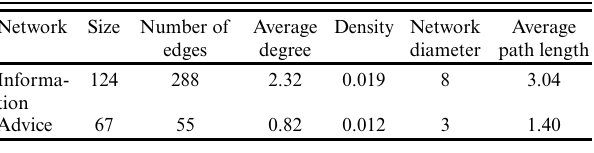
Table 3. Summary of network metrics for the information and advice